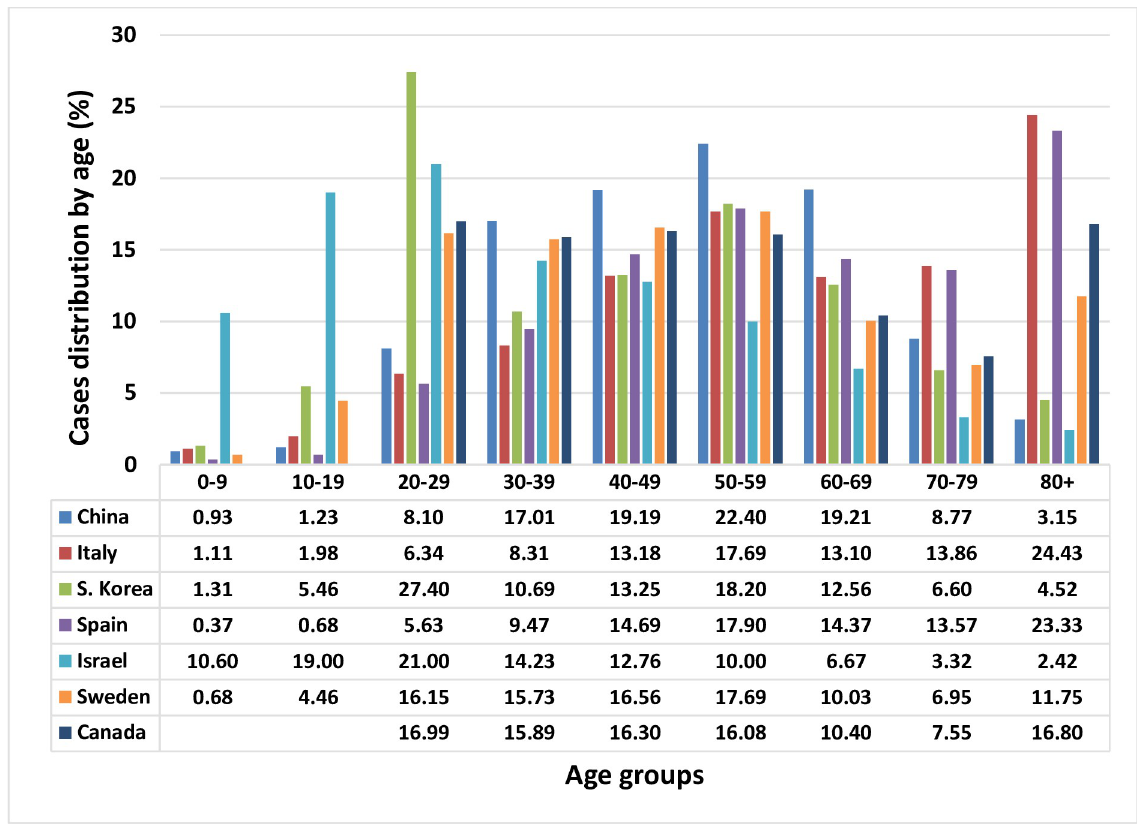
Fig 1. Distribution of cases (%) by age for seven countries–China, Italy, S Korea, Spain, Israel, Sweden, and Canada.